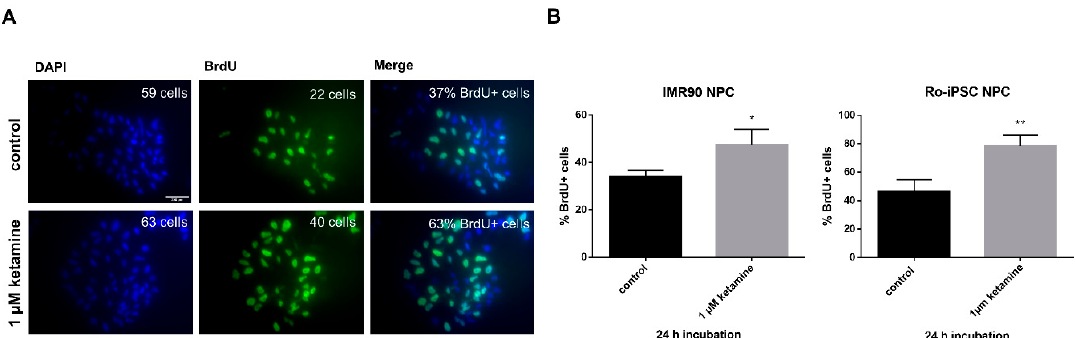
Figure 4. Ketamine induction of proliferation detected by 5-bromo-2’-deoxyuridine (BrdU) staining in NPCs. ( A ) Representative images of BrdU+ labeled Ro-iPSC NPCs, scale = 200 µm. NPCs were treated with 1 µM ketamine or 0.01% dimethyl sulfoxide (DMSO) control for 24 h, before cells were incubated with 10 µM BrdU labeling solution for an additional 4 h. ( B ) A histogram showing BrdU-expressing cells. BrdU incorporation was quantified by the calculation of BrdU+ cells as a percentage of the total number of 4 ′ ,6-diamidino-2-phenylindole (DAPI)-labeled nuclei using ImageJ (Fiji) for image analysis. Data represent the means of three independent experiments. Error bars were calculated using ±SEM. p-values were calculated against the 0.01% dimethyl sulfoxide (DMSO) control using the unpaired two-tailed t-test.